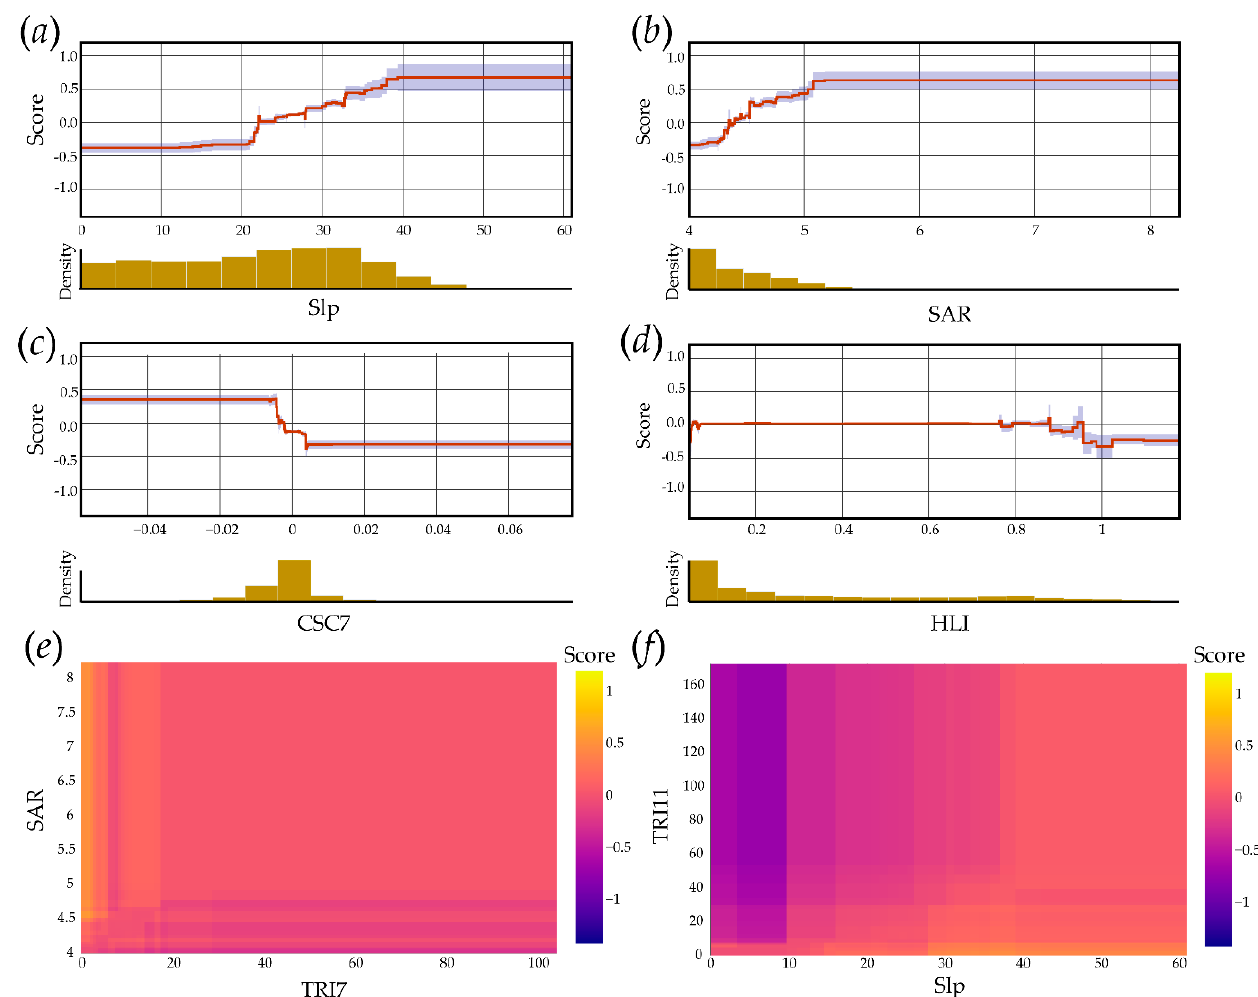
Figure 10. EBM functions for a subset of variables and two-dimensional interaction plots for a subset of the predictor variables for the NARV model. These plots offer explanations for the global model. ( a ) The slope; ( b ) the surface area ratio; ( c ) cross-sectional curvature; ( d ) the heat load index; ( e ) interaction between the topographic roughness index calculated using a 7 cell radius and the surface area ratio; ( f ) interaction between topographic slope and the topographic roughness index calculated using an 11 cell radius.